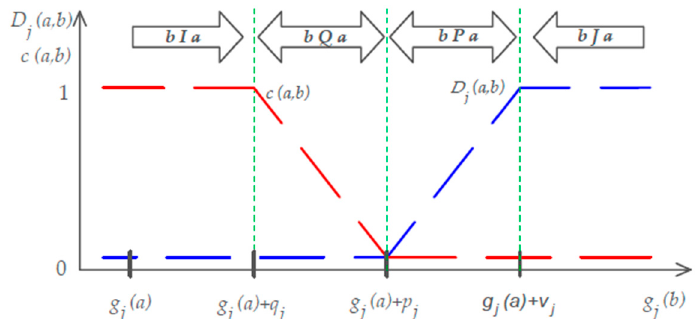
Figure 1. The four-state preference model (indifference I , weak preference Q , strong preference P , incomparability J ) constructed on the basis of threshold values q j , p j , v j [31].